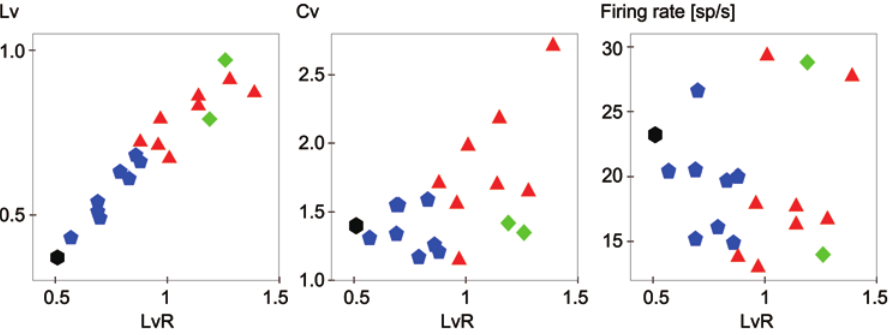
Figure 5. Correlation of various metrics. Mean values of Lv , Cv , and firing rate from the 19 data sets are plotted with reference to the mean LvR . Correlations are r=0.95, 0.54, and 0.05, respectively. The black hexagons, blue pentagons, red triangles, and green squares represent the primary motor, higher-order motor, visual, and prefrontal areas, respectively, as described in Figure 4.